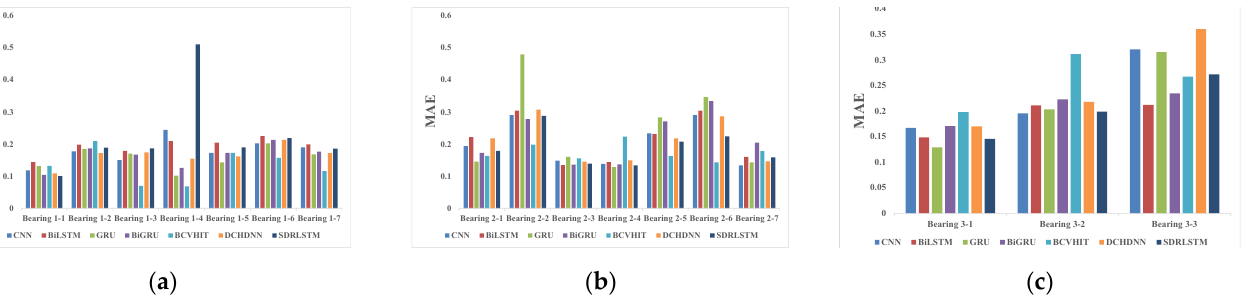
Figure 13. The MAE of different rolling bearings for each working condition in the comparative experiment: ( a ) Condition 1; ( b ) Condition 2; ( c ) Condition 3. Table 7. Statistical results of the comparative method under the different working conditions in Test 1.